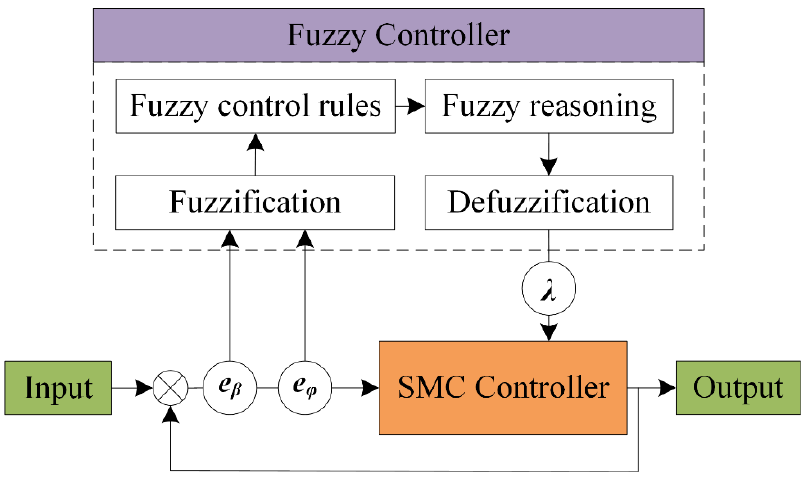
Figure 4. The structure diagram of the fuzzy controller.